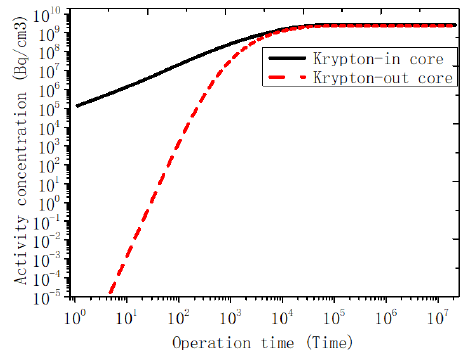
Figure 6. Krypton concentration in and out of the core varies with time after start-up